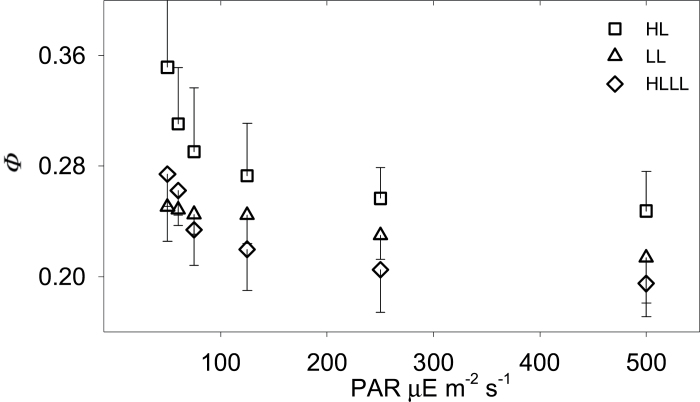
Leakiness (ϕ) resolved from online isotopic discrimination during photosynthesis (Δ) by means of a full isotopic discrimination model for HL plants (squares), LL plants (triangles), and HLLL plants (diamonds). Error bars represent one SE (n = 6).